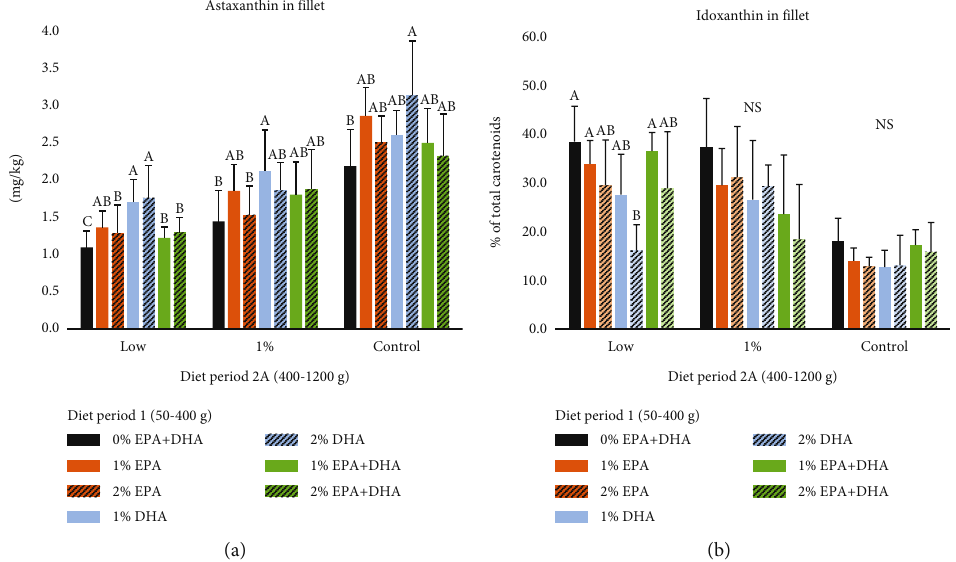
Figure 1: Fillet astaxanthin (a) and idoxanthin (b) in 1200 g salmon grouped by diet in period 1 (7 diets from 50 to 400 g containing 0, 1, and 2% EPA and DHA, and EPA and DHA in combination) and by diet in period 2A (3 diets from 400-1200 g) containing 1.7% EPA +DHA (Control), 1% EPA +DHA, and 0.2% EPA+DHA (low). Values are mean per treatment ± SEM . n = 3 tanks per treatment. Signi fi cant di ff erences between diet groups in period 1 are indicated by di ff erent letters ( P < 0 : 05